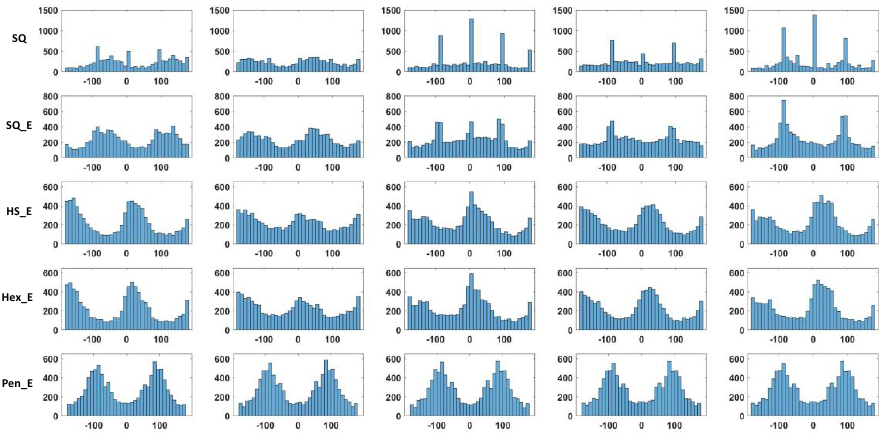
Figure 9. The angular characteristic of sensor grid structure. The five columns of figures are the histograms of the gradient orientation from five images in the database. From the first to the fourth row, the five image types are SQ, SQ_E, HS_E, Hex_E and Pen_E. In Figure 10, from top to bottom, the five ANCHOR curves show the normalized average values of 23 histograms of the gradient orientation. The result is consistent to what we conclude from Figure 9. The right Figure 10 shows the comparison between ANCHORs of Pen_E (black) and Hex_E (green). These ANCHORs together, representing combination of two types of sensor arrangements,